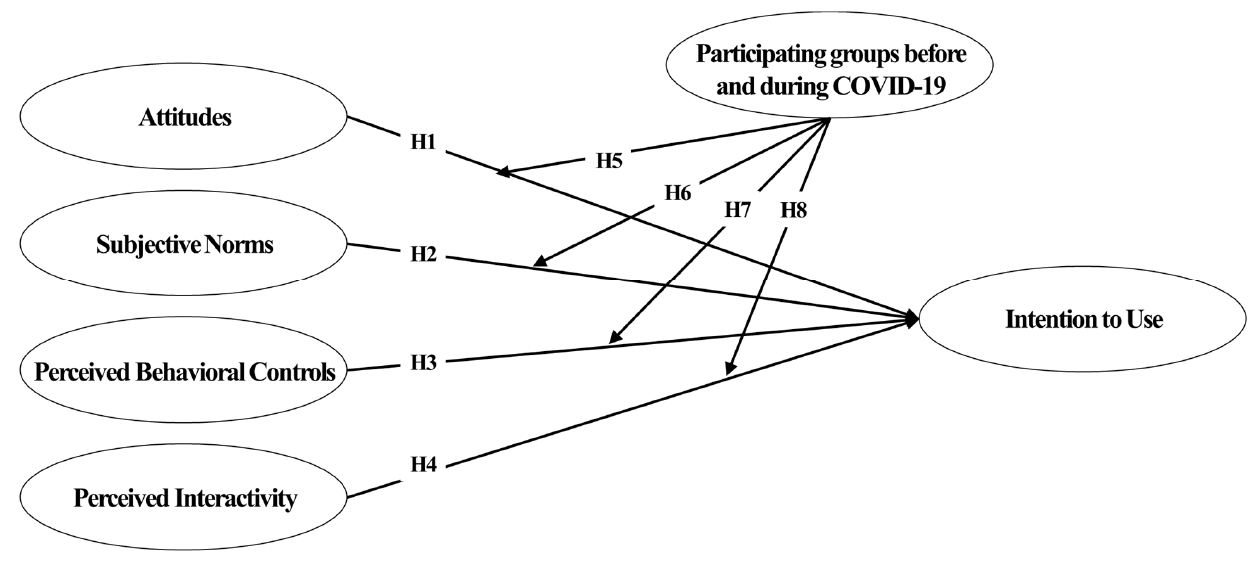
Figure 3. Research model.